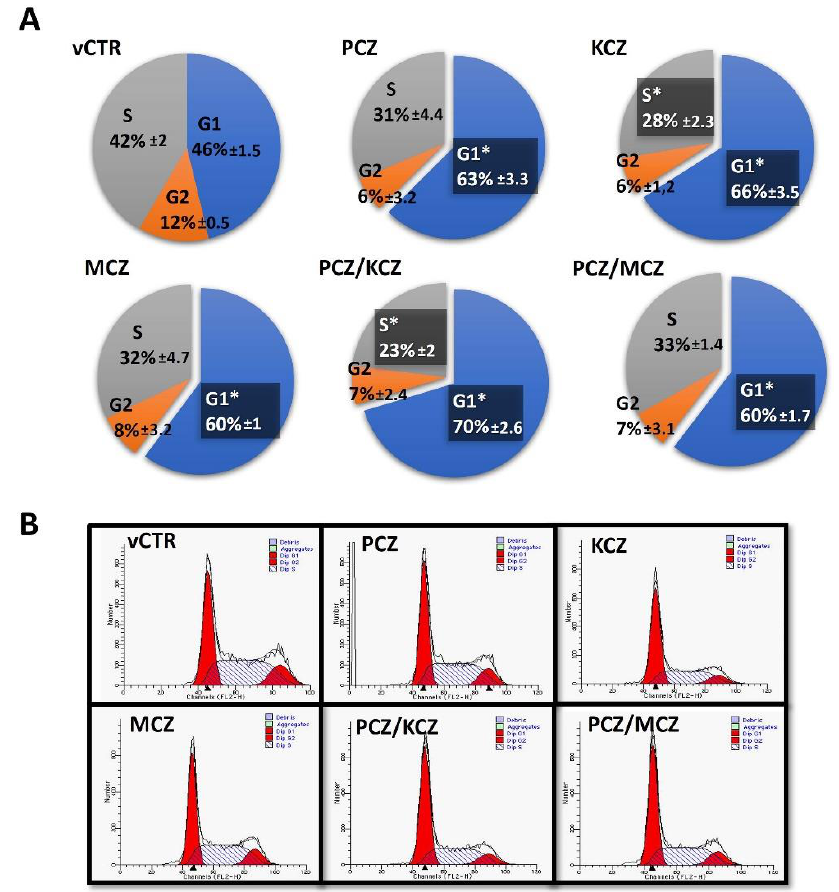
Figure 3. Effects of azole exposure on the distribution of cell cycle phases in TM4 cells. Cells were treated with PCZ (18.3 µM), KCZ (18.6 µM), MCZ (8.6 µM), and their mixtures for 48 h, and compared to the vCTR. The distribution of cell cycle phases was assayed using PI staining and flow cytometry analyses. The percentage of cells in each phase is presented at 48 h of incubation ( A ), and represents the mean ± SE of three independent experiments; one-way ANOVA followed by Dunnett’s test; * p < 0.05 compared to the vCTR. ( B ) Representative images of flow cytometric profiles after 48 h of incubation in the absence (vCTR) or in the presence of azoles.